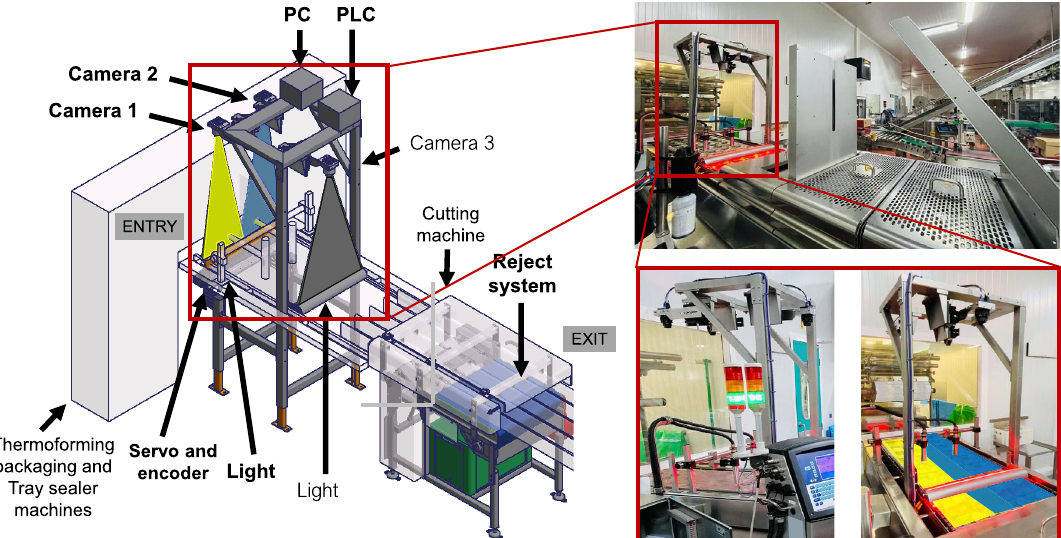
Figure 1. A schema of the main components of the proposed computer vision system (highlighted in bold) with some views of the real scenario. The cameras are placed between the tray sealer and cutting machinery; a servo and an encoder, connected to a Programmable Logic Controller (PLC), control the speed of food packages movement, the position of the products, and when the reject system has to act. Monochrome line scan Camera 1 and Camera 2 are triggered with different exposure times to acquire images for the sealing test. Camera 3 acquires images for the serigraphy and traceability tests. Then, the acquired images are processed to determine how the reject system has to